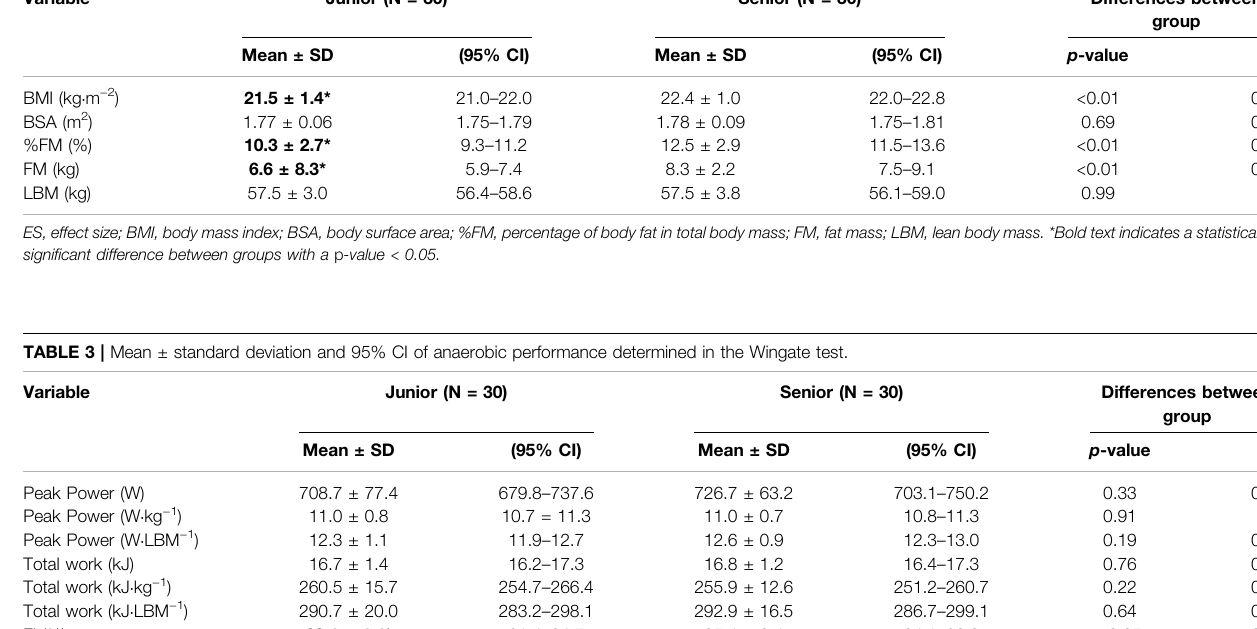
TABLE 2 | Mean ± standard deviation and 95% CI of anthropometrics variables. Variable